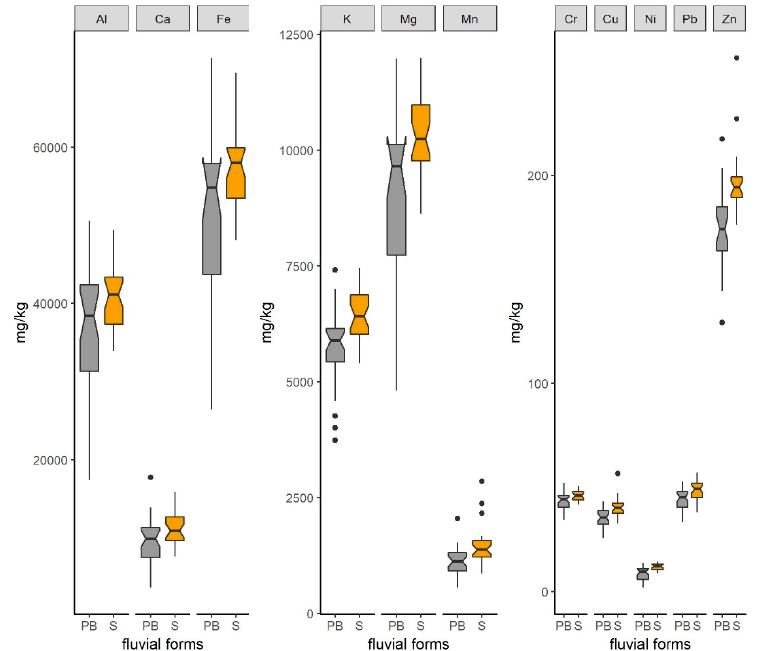
Figure 2. The accumulation differences between the two landforms (unit: mg/kg; PB: point bar—grey, S: swale—orange; whiskers: 1.5 × interquartile range, •: outliers; box: lower quartile, median, upper quartile; notch: 95% confidence interval of the median).